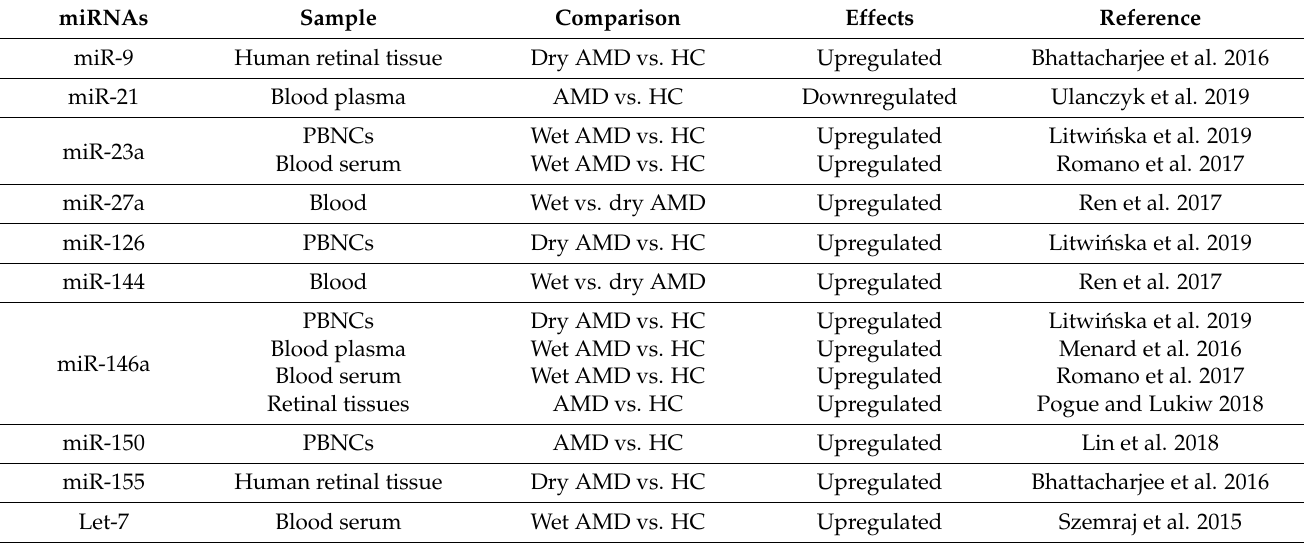
Table 1. miRNAs associated with age-related macular degeneration